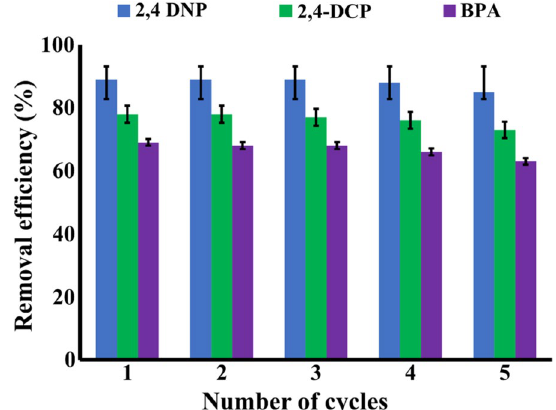
Fig. 10 Fe 3 O 4 @MAA-βCD for the removal of selected phenolic compounds. Conditions: (298 K, 10 mL of analyte solution (10 mg L − 1 ) at pH 2, 7, and 6, 20 mg sorbent dose, and 60 min shaking time